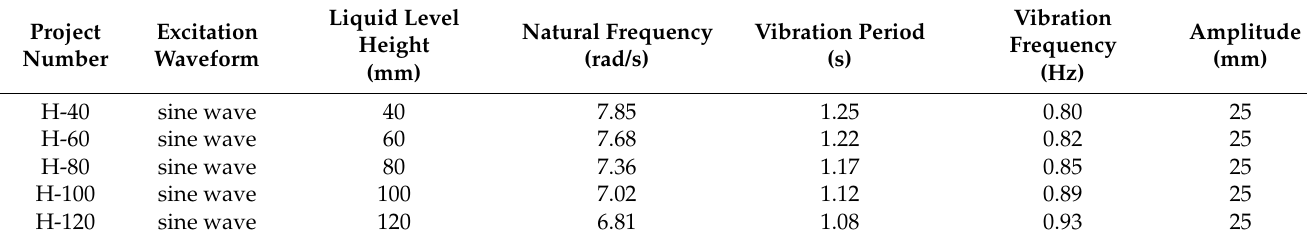
Table 1. The harvester and experimental condition